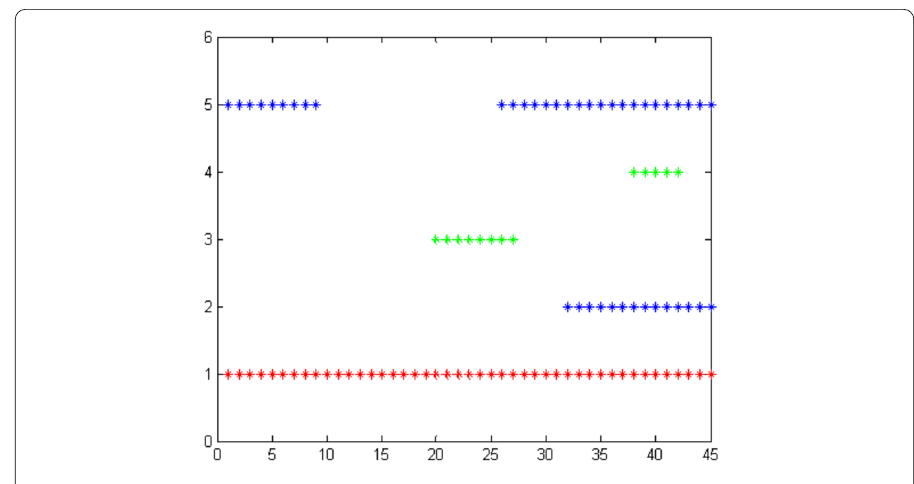
Figure 10 Internal execution interval